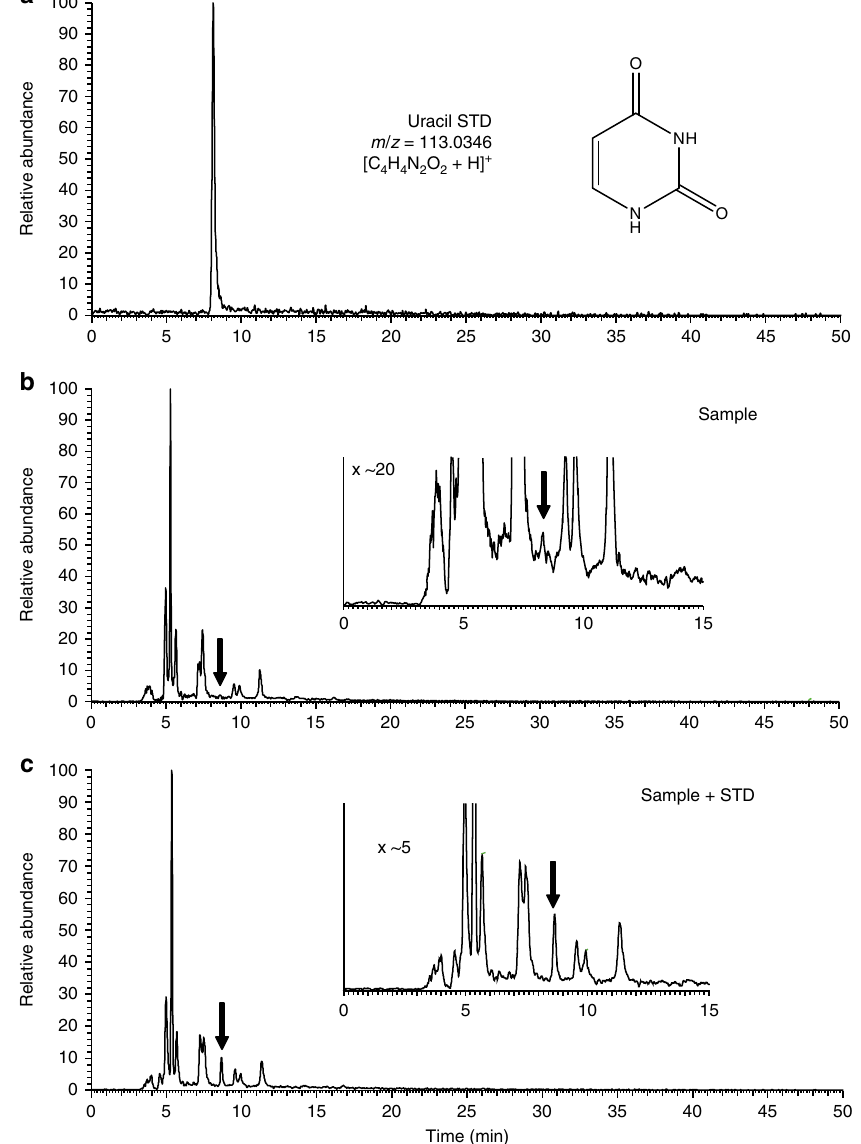
Fig. 2 Identi fi cation of uracil in the organic residues. Mass chromatograms of a the uracil standard, b the analyte sample and c the co-injected mixture of uracil standard and analyte sample at a mass-to-charge ratio ( m/z ) of 113.0346. A C18 separation column was used for the analysis by HPLC/HRMS. The solid arrow indicates the presence of uracil. The inset shows an enlarged spectrum from 0 to 15 min. The intensity of the peak at ~8.6 min, which is associated with uracil (panel a ), is higher in the co-injected sample (panel c ) than in the analyte-only sample (panel b